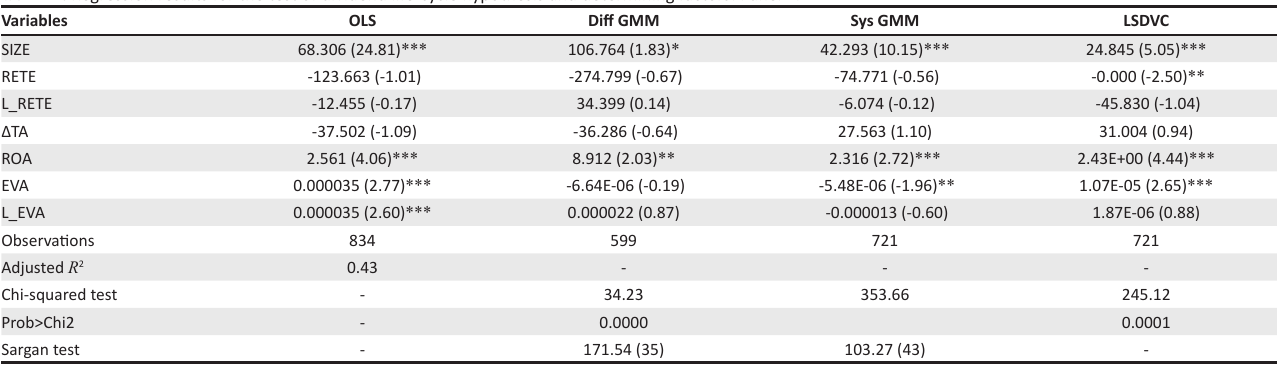
TABLE 2: Regression results for the test of dividend life-cycle hypothesis and determining factors: Panel 1.